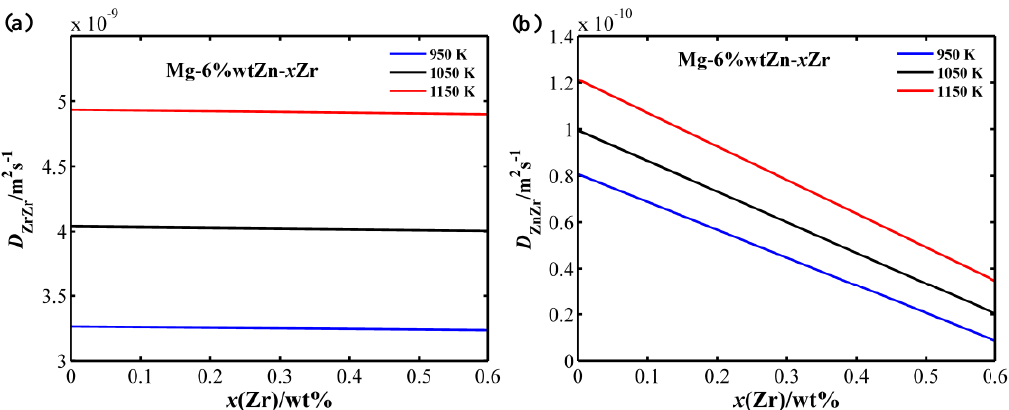
D ( a ) of Zn atoms and the cross Figure 9. Dependence of the main interdiffusion coefficient Figure 9. Dependence of the main interdi ff usion coe ffi cient D ZnZn ( a ) of Zn atoms and the cross Z n Z n interdi ff usion coe ffi cient D ZrZn ( b ) of Zr atoms on the composition of Zn in the liquid Mg- x Zn-0.6 wt% D ( b ) of Zr atoms on the composition of Zn in the liquid Mg- x Zn-0.6 interdiffusion coefficient ZrZn Zr alloys at 950 K, 1050 K, and 1150 wt% Zr alloys at 950 K, 1050 K, and 1150 K.